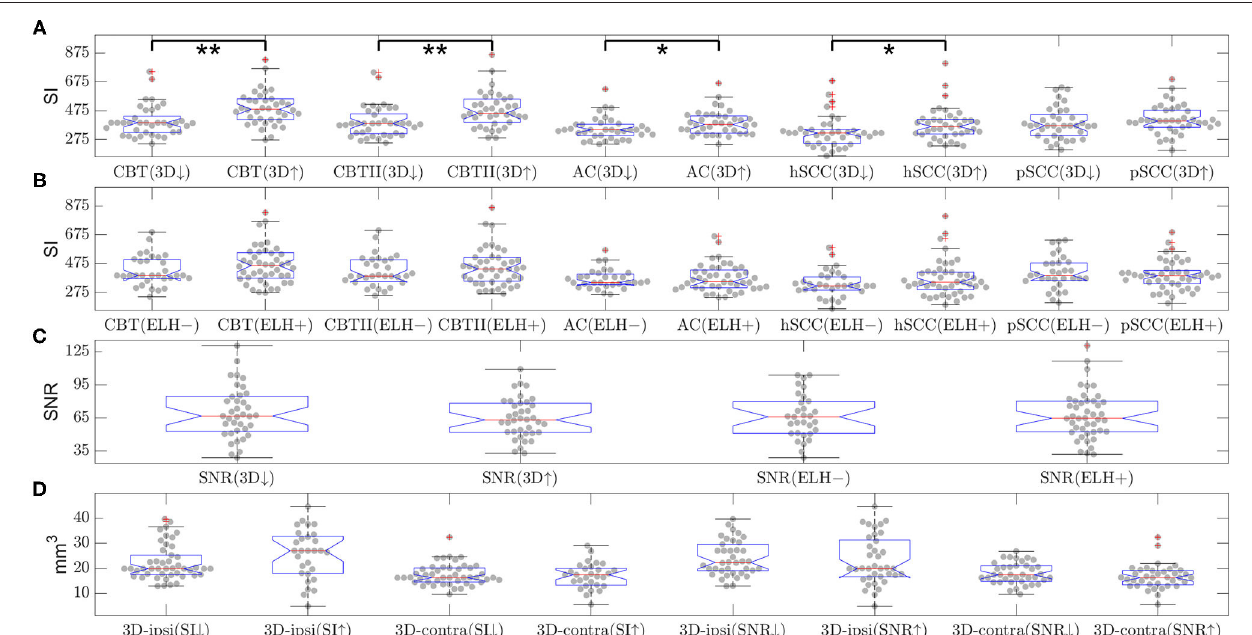
FIGURE 5 | Influence of endolymphatic hydrops (ELH) on signal intensity (SI) or signal-to-noise ratio (SNR) and vice versa (belonging to question iii). The top two rows (A,B) show the signal intensity (SI) in various areas of the inner ear. The SI values are split by either (A) 3D-quantification values (below or above median, indicated by a downward-arrow or an upward-arrow) or (B) endolymphatic hydrops (ELH) being absent [“–”] or present [“ + ”]. Here, “ELH absence” is defined as the average semi-quantitative (SQ) rating being zero and “ELH presence” is defined as the average rating being non-zero. Significant differences are indicated by black lines and p-values for the group differences evaluated with two-sample t -test or rank-sum test (** p < 0.001 and * p < 0.05). The third row (C) shows the mean SNR split by 3D-quantification values (below or above median; indicated by a downward-arrow or an upward-arrow), as well as the mean SNR split by ELH being absent [“–”] or present [“ + ”], where presence is defined as ELH being non-zero and absence as ELH rating being zero. The group differences were evaluated with the two-sample t -test and the rank-sum test; neither of these was significant. The fourth row (D) shows the 3D-quantification values split by mean SI values (below or above median; indicated by a downward-arrow or an upward-arrow), as well as the 3D-quantification values split by SNR values (below or above median; indicated by a downward-arrow or an upward-arrow). The group differences were evaluated with the two-sample t -test and the rank-sum test; neither of these was